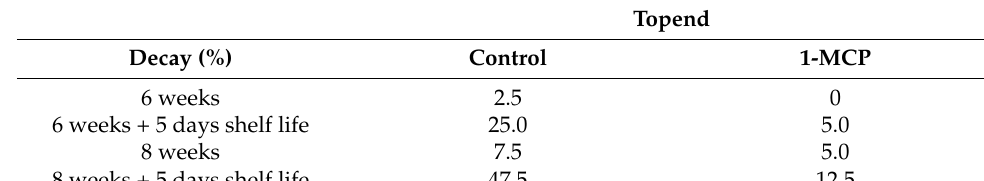
Table 2. Decay of ‘Topend’ plum during storage.